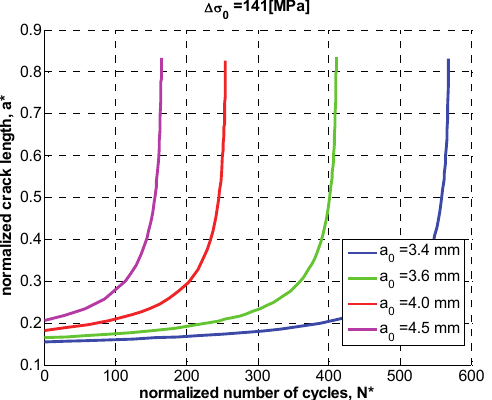
Figure 8: a*-N* curves for different stress ranges, Δσ *, while maintaining the initial crack size, a 0 *